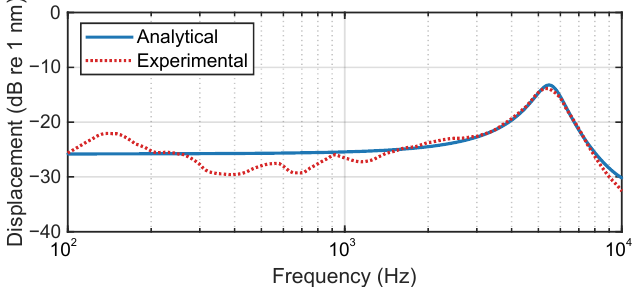
Figure 5. Analytical and experimental spectrum of the displacement of a membrane specimen obtained with white noise excitation, where a resonance occurs at about 5.5